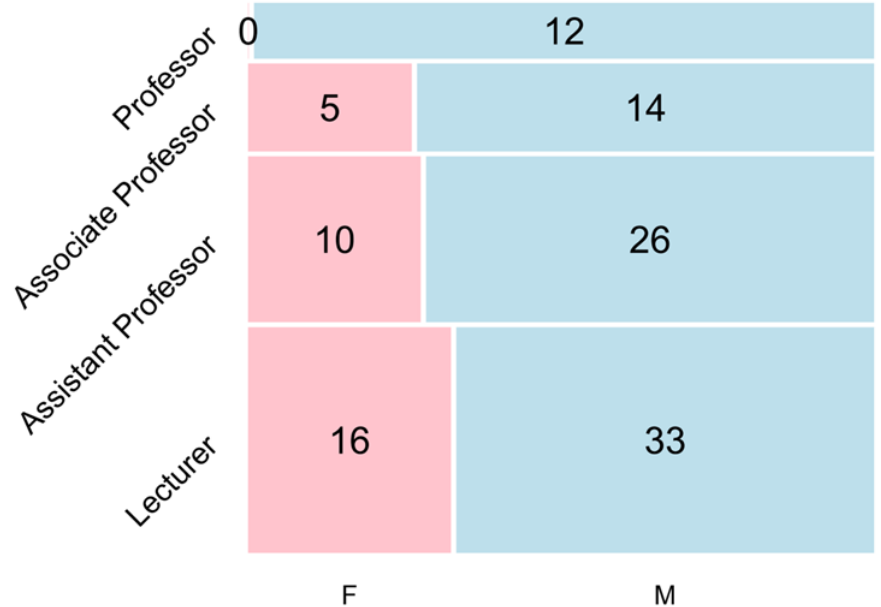
Figure 1. Gender and faculty rank of academic family medicine faculty.